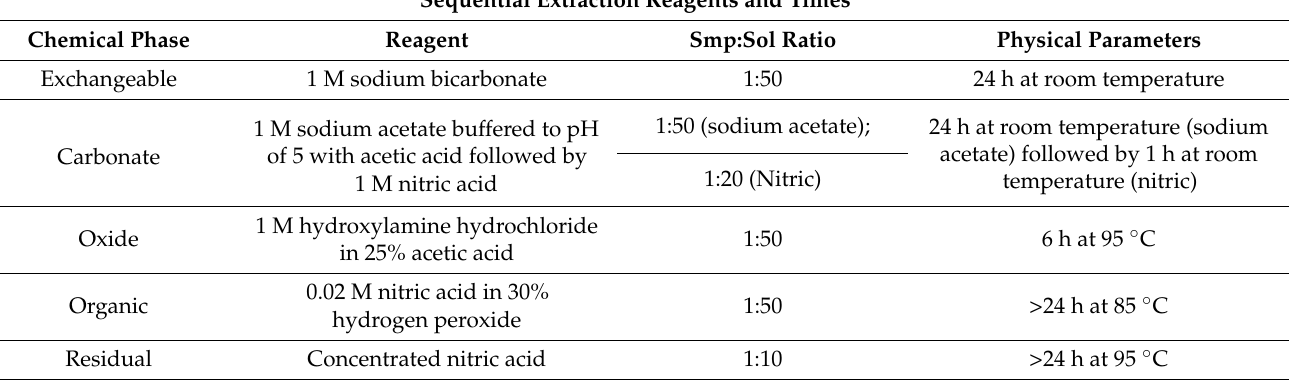
Table 1. The list of parameters, reagents, and chemical phases used during the sequential extraction. Extracts were performed using increasingly aggressive reagents, progressing down the table. Smp:Sol is abbreviated for sample to solution ratio. Sequential Extraction Reagents and